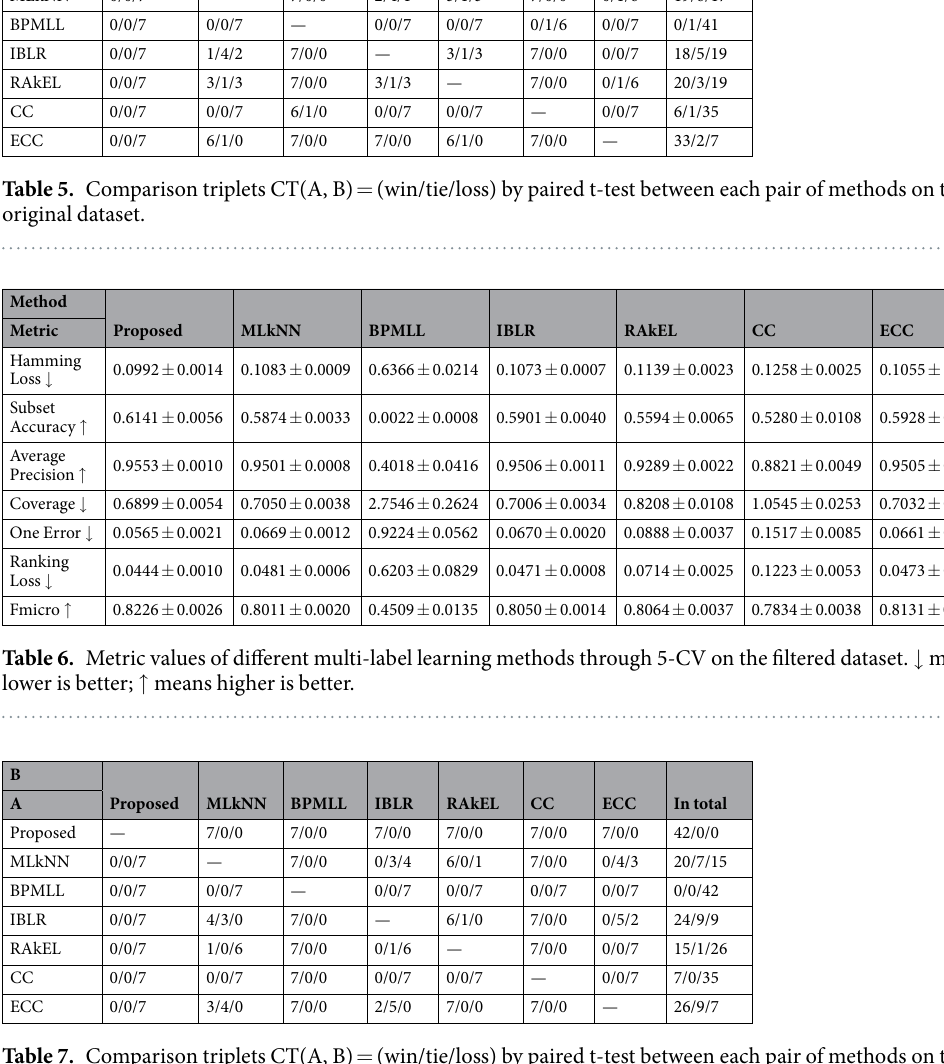
Table 7. Comparison triplets CT(A, B) = (win/tie/loss) by paired t-test between each pair of methods on the filtered